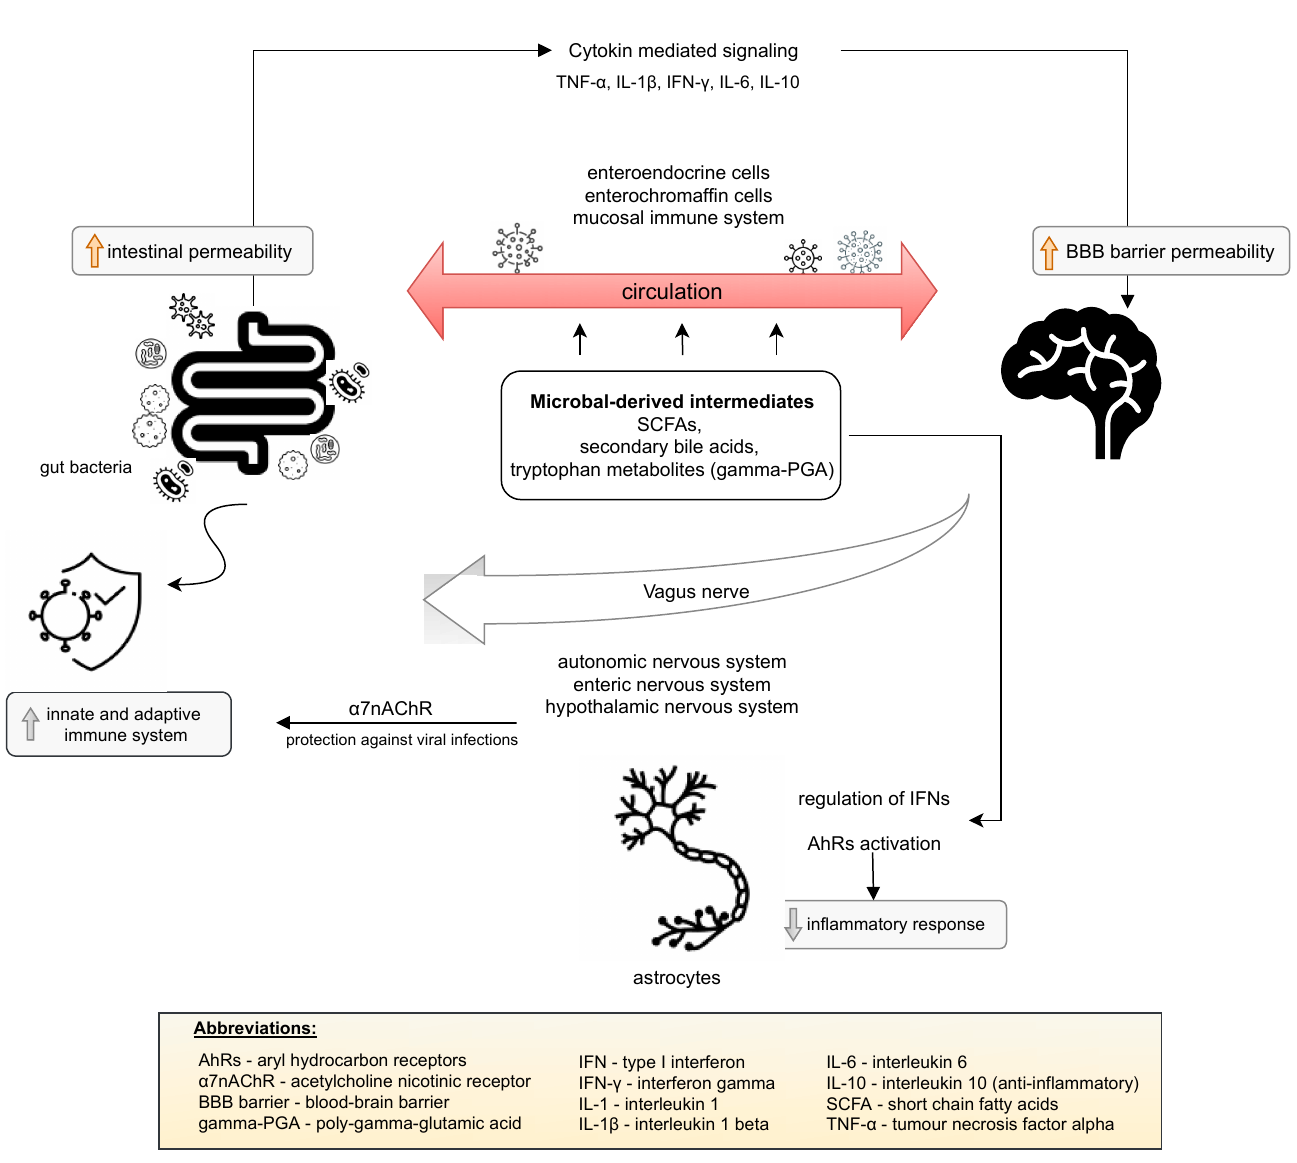
Figure 1. Bidirectional interaction of the gut–brain axis.